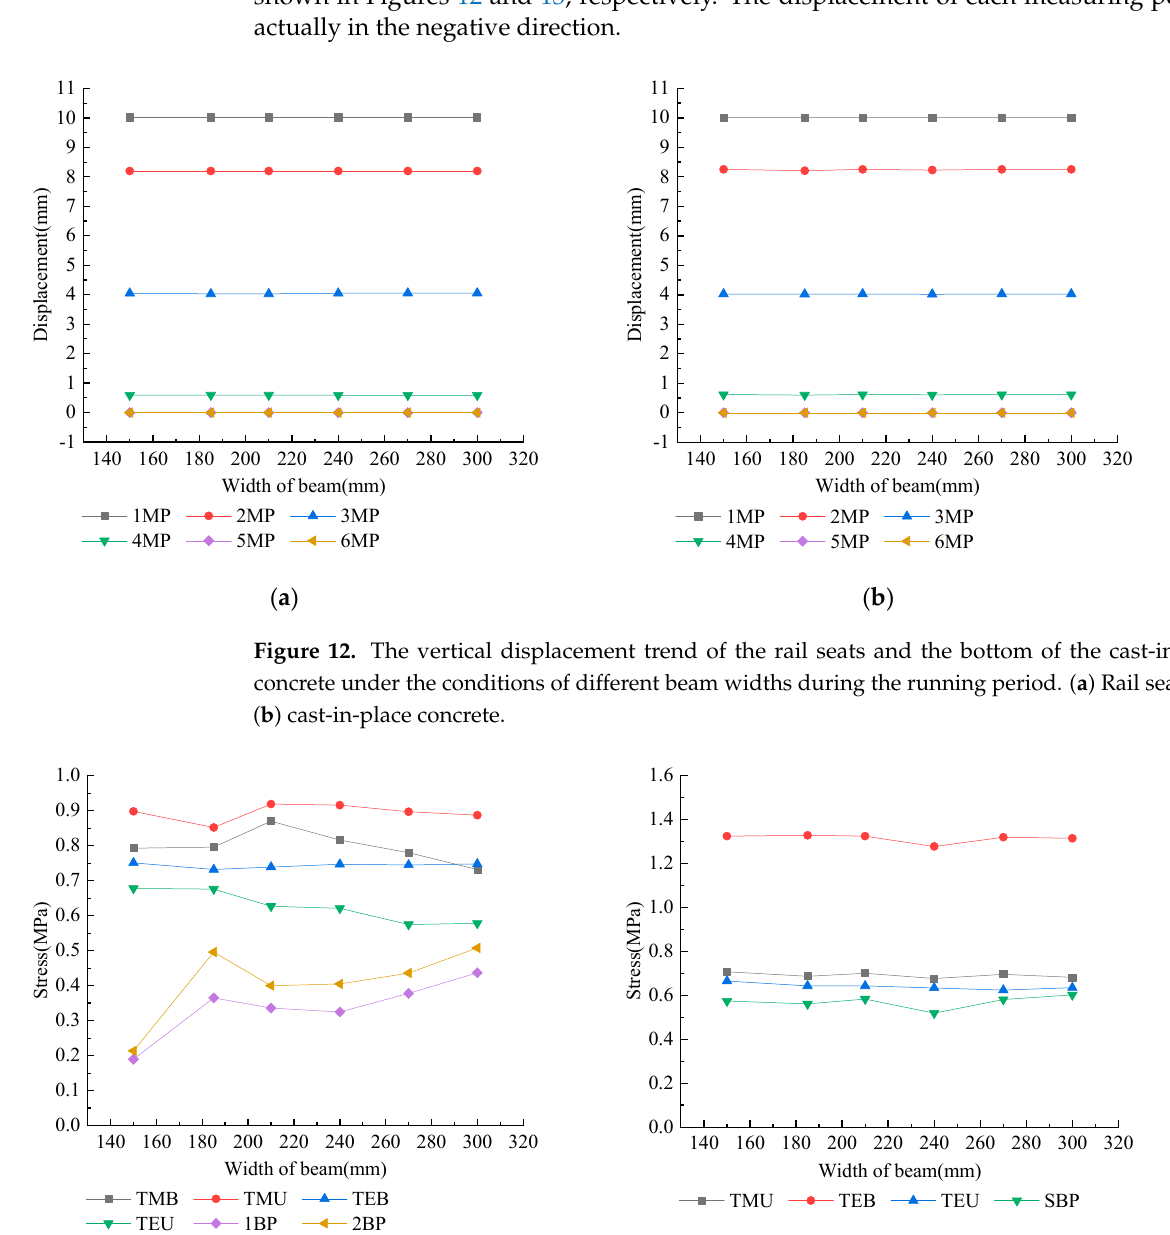
( b ) Figure 13. The change trend of the cast-in-place concrete stress under different beam widths during the running period. ( a ) Rail seats and ( b ) cast-in-place concrete. According to Figure 13, the stress of the existing concrete structure is generally greater than the stress of the rail seats. For the rail seats, when the beam width is 150 mm,